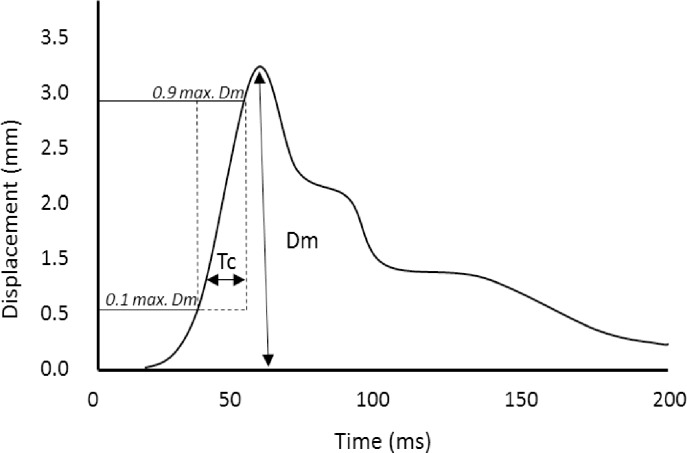
Typical Tensiomyography muscle contraction displacement-time curve.Contraction time (Tc) is calculated as the time (ms) between 10% and 90% of the maximal Dm value of the displacement-time curve.